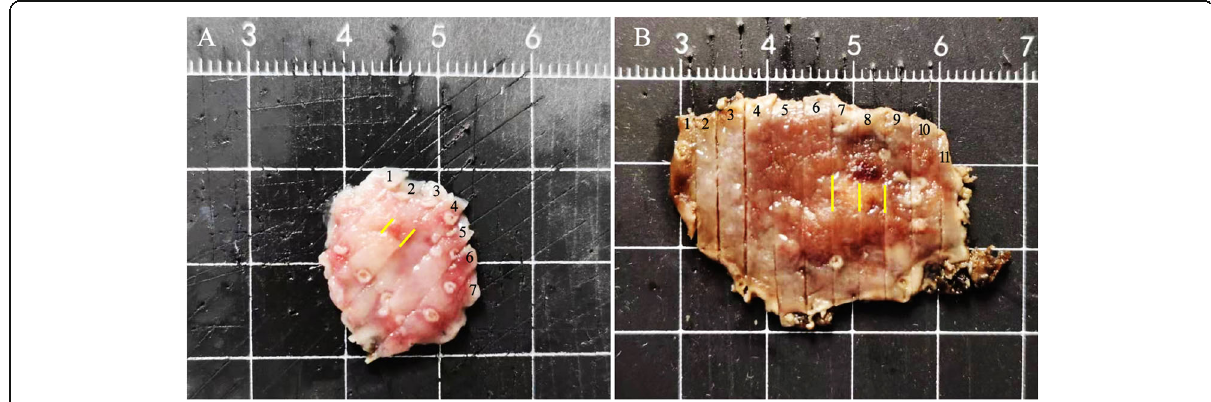
Fig. 2 Mapping of the endoscopic submucosal dissection specimen based on histology. a GA-FG distributed at a slightly depression lesion measuring 5 mm × 4 mm (yellow line) (case 5); b showed a slightly elevated lesion measuring 12 mm × 10 mm (yellow line) (case